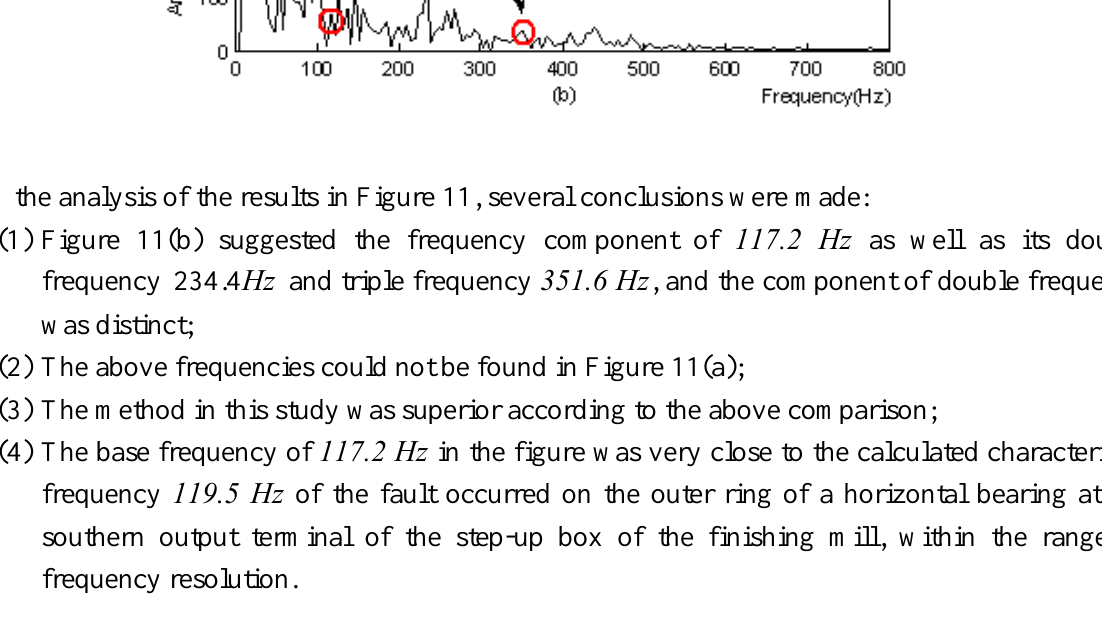
Figure 12. Schematic damage of bearing outer-ring of axis I at the southern output terminal of the step-up